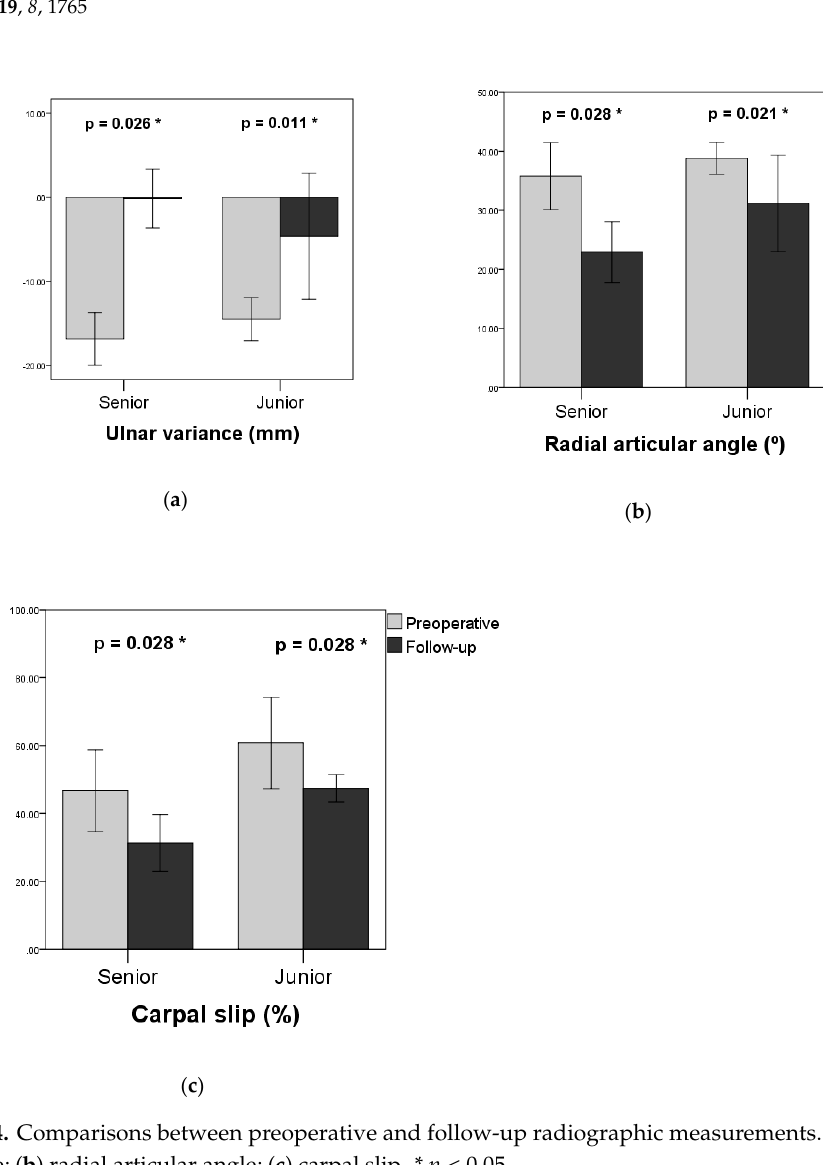
Figure 4. Comparisons between preoperative and follow-up radiographic measurements. ( a ) Ulnar variance; ( b ) radial articular angle; ( c ) carpal slip. * p < 0.05.